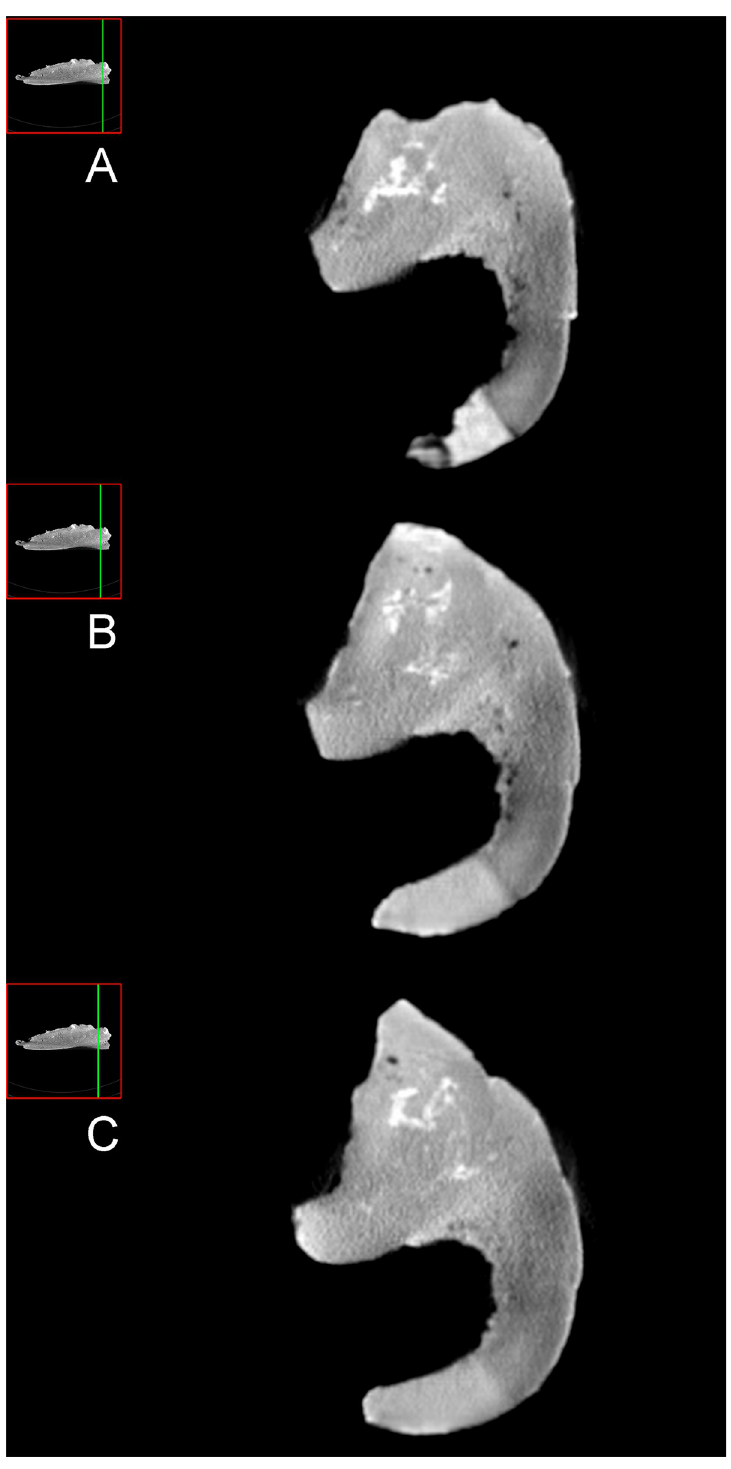
Fig 6. MQ98-II-1 dentary tomographic slices in the axial plane. A) General view illustrating the scan area and CT image of axial slice no. 416. B) General view illustrating the scan area and CT image of axial slice no. 406. C) General view illustrating the scan area and CT image of axial slice no.